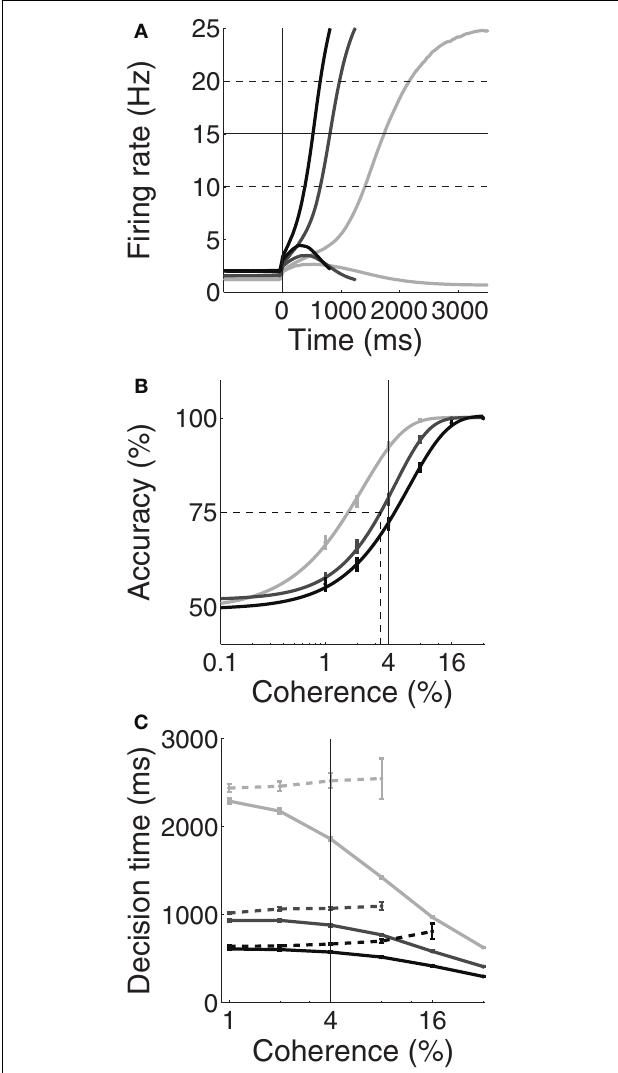
FIGURE 2 | Trading speed and accuracy as a function spatially non-selective input I 0 . Simulated neural activity (A) and resulting psychometric (B) and chronometric (C) curves for neutral ( I 0 = 321pA, medium gray), speed ( I 0 = 325pA, black) and accuracy ( I 0 = 316pA, light gray) conditions. (A) Trial-averaged firing rates for coherence c = 4%. For each condition, the upper and lower curves show the mean rate over all correct trials for the target and distractor populations respectively. The vertical line at 0ms indicates the time of simulated motion onset. To the left of this line, pre-stimulus/baseline firing rates are higher (lower) under speed (accuracy) conditions compared to the neutral condition. Thus, the threshold-baseline difference is smaller (larger) under speed (accuracy) conditions. The solid horizontal line shows the “default” choice threshold θ = 15Hz used by Wong and Wang (2006). The dashed horizontal lines depict other possible thresholds. (B) The percentage of correct trials as a function of coherence. The data are fitted with a Weibull function for each condition. Error bars show standard error. The solid vertical line indicates coherence c = 4%, corresponding to the firing rates in (A) . The dotted lines indicate the coherence value at 75% accuracy (see Figure 3A ). (C) Mean decision times over coherence for correct (solid) and error (dashed) trials for each condition. Error bars show standard error. The vertical line indicates coherence c = 4%, corresponding to the firing rates in (A)